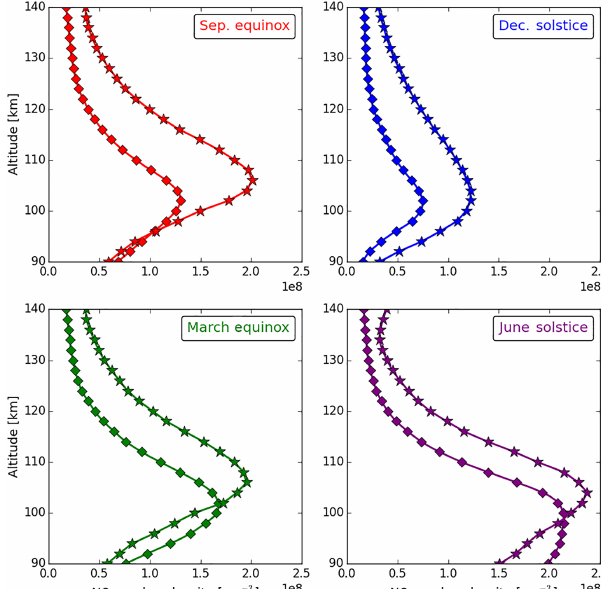
Figure 5. Seasonal variability of the lower thermospheric NO num- ber density profile for SOFIE (diamonds) and WACCM (stars). Each season represents a multi-year mean of a 90-day period cen- tred on the solstice or equinox. The September equinox and De- cember solstice correspond to Antarctic spring and summer, respec- tively, while the March equinox and June solstice correspond to the Antarctic autumn and winter season,